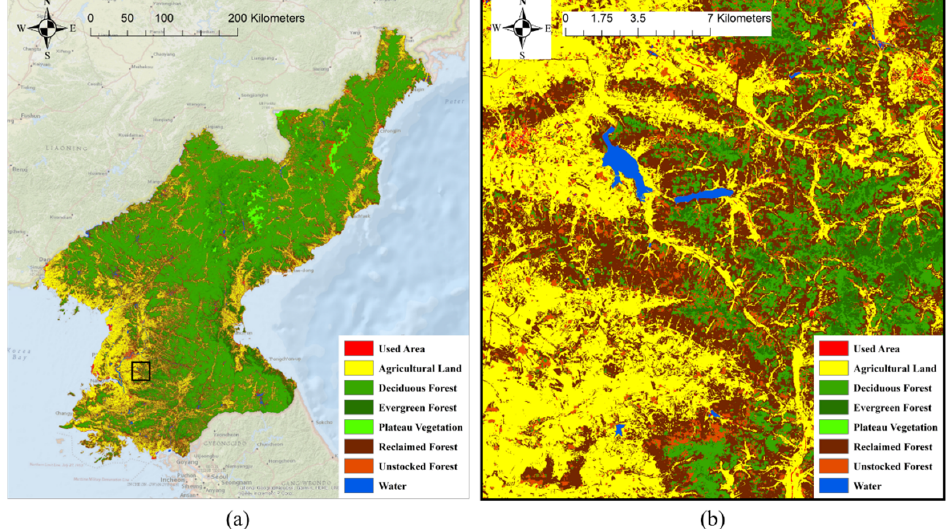
Figure 7. U-Net based vegetation phenological classification of North Korea: ( a ) land cover map of North Korea; and ( b ) detailed view of the Pyongyang region. Table 1. Confusion matrix for the land cover classification of North